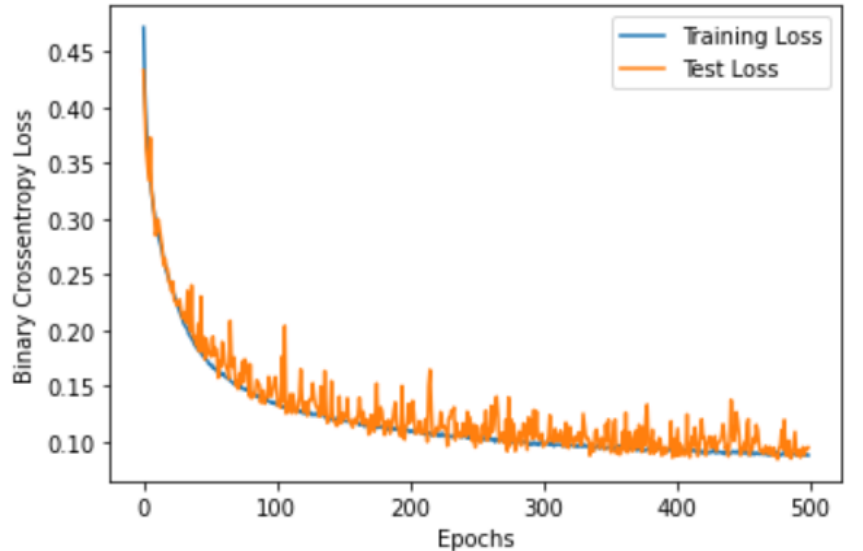
Figure 5. The loss curve for the EMG data classification of the right side using the proposed CNN architecture.